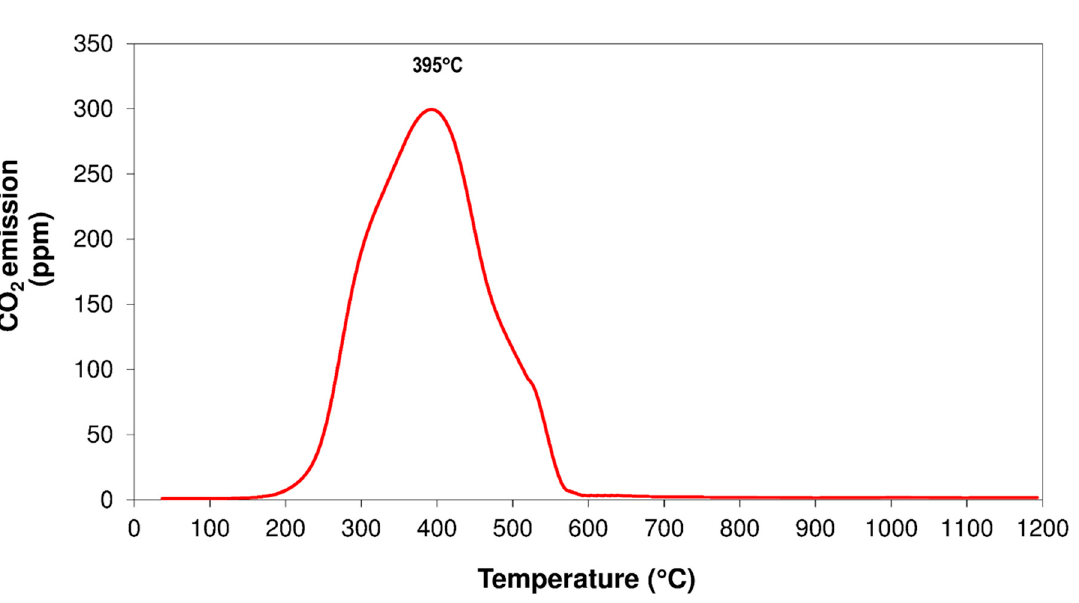
Figure 7. SO 2 curve emission for sample BCS-CRM 348 Ball clay.